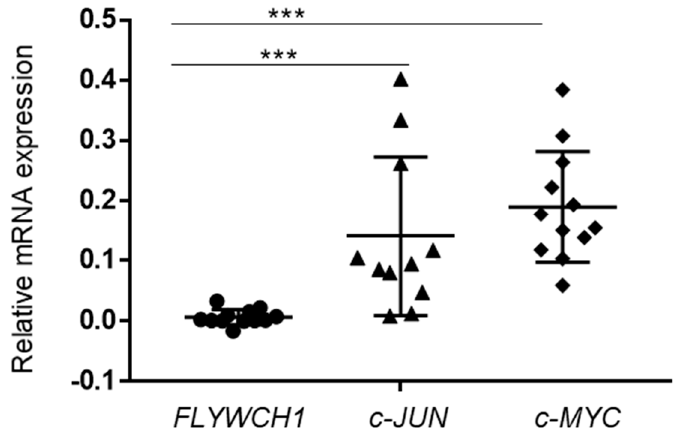
Figure 5. Comparison of FLYWCH1 , c-MYC , and c-JUN mRNA expression in AML primary samples. A qRT-PCR analysis of FLYWCH1 , c-JUN , and c-MYC mRNA expression in a cohort of twelve AML samples. Data are mean ± SD ( n = 3; *** p < 0.001).